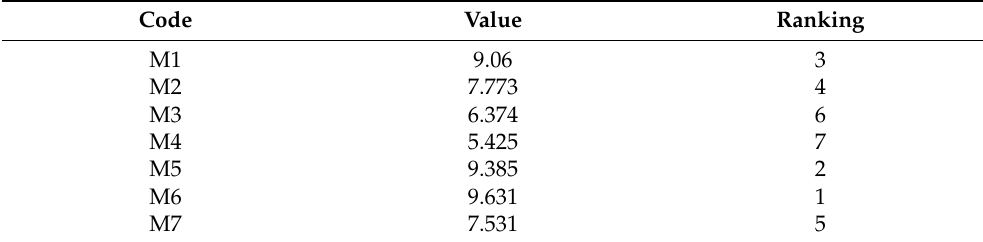
Table 21. DOMINIC ranking.